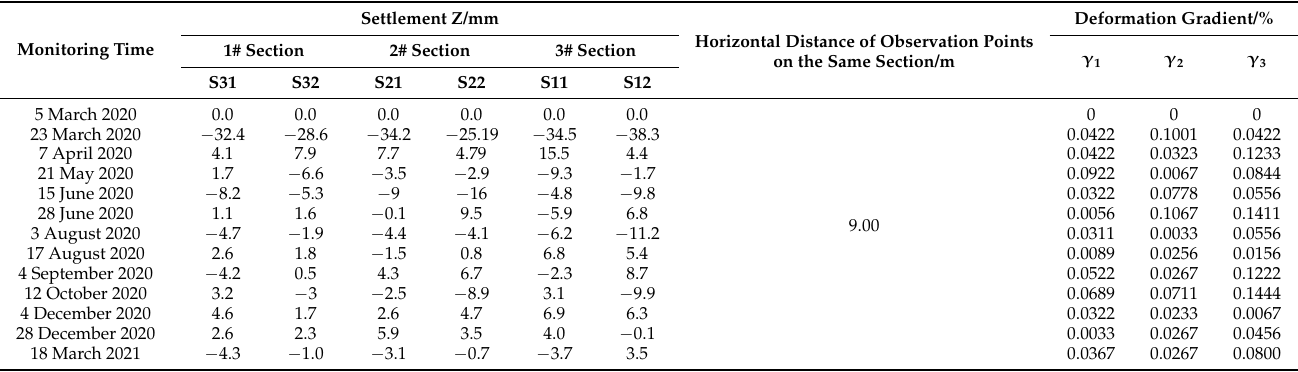
Table 4. Gradient calculation